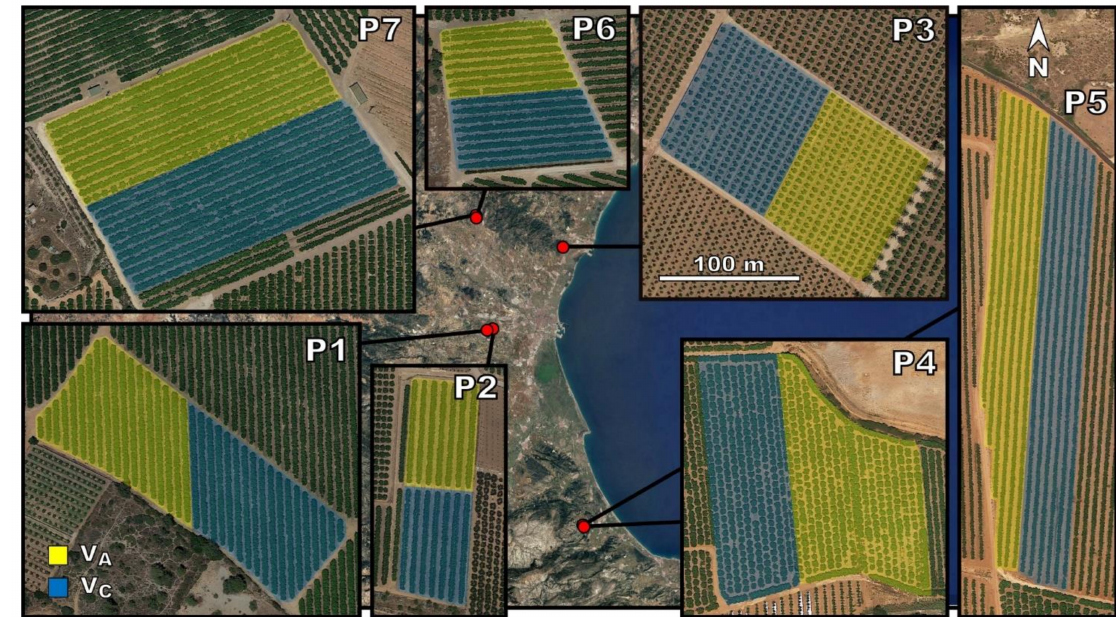
Figure 1. Location and maps of the seven experimental plots (P1–P7). The V C (conventional volume) block is blue shaded and the V A (adjusted volume) block is yellow shaded. Date of satellite images: 5 July 2016; source: Google Earth Pro 7.3.2. Geographic coordinates: P1 (39 ◦ 26 (cid:48) 32 (cid:48)(cid:48) N, 0 ◦ 33 (cid:48) 23 (cid:48)(cid:48) W), P2 (39 ◦ 26 (cid:48) 43 (cid:48)(cid:48) N, 0 ◦ 32 (cid:48) 18 (cid:48)(cid:48) W), P3 (39 ◦ 39 (cid:48) 14 (cid:48)(cid:48) N, 0 ◦ 18 (cid:48) 26 (cid:48)(cid:48) W), P4 (38 ◦ 56 (cid:48) 46 (cid:48)(cid:48) N, 0 ◦ 14 (cid:48) 15 (cid:48)(cid:48) W), P5 (38 ◦ 56 (cid:48) 56 (cid:48)(cid:48) N, 0 ◦ 14 (cid:48) 32 (cid:48)(cid:48) W), P6 (39 ◦ 43 (cid:48) 43 (cid:48)(cid:48) N, 0 ◦ 35 (cid:48) 28 (cid:48)(cid:48) W) and P7 (39 ◦ 43 (cid:48) 58 (cid:48)(cid:48) N, 0 ◦ 35 (cid:48) 33 (cid:48)(cid:48) W). Table 1. Characteristics of the experimental plots: area, planting pattern, vegetation density, canopy dimensions, canopy volume, TRV (tree row volume) and pruning level.